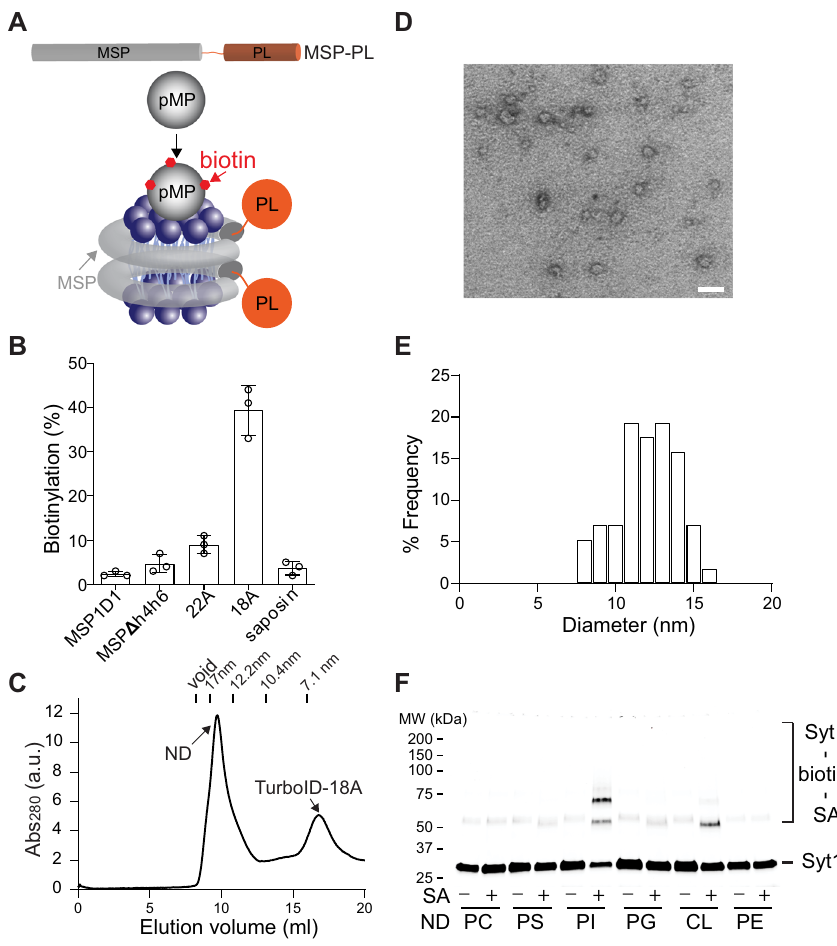
Fig. 2 Developing nanodisc-ID to characterize protein – lipid interactions. A Illustration of nanodisc-ID. Top, PL enzymes were fused to MSPs for developing the nanodisc-ID approach. Bottom, binding of pMPs to nanodiscs results in biotin labeling by PL enzymes. B The indicated MSPs were fused with TurboID and were then used to form nanodiscs containing PI lipids. PL ef fi ciencies of syt1 by these nanodiscs were quanti fi ed. Data are shown as mean ± s.d., n = 3 independent experiments. C Representative size-exclusion chromatography (SEC) pro fi le of TurboID-18A NDs containing PI lipids. D Representative negative stain image of the fractions corresponding to NDs from SEC in C . Scale bar: 20 nm. E Quanti fi cation of TurboID-18A ND diameters containing PI lipids from negative stain EM ( n = 57). F The cytosolic domain of synaptotagmin-1 (syt1) was labeled with 5-IAF and incubated with TurboID- 18A nanodiscs containing 10% of the indicated lipids and 90% of PC, followed by PL reactions. Samples, with or without the addition of SA, were subjected to SDS-PAGE and in-gel fl uorescent imaging. PC 1,2-dioleoyl-sn-glycero-3-phosphocholine, PS 1,2-dioleoyl-sn-glycero-3-phospho-l-serine, PE